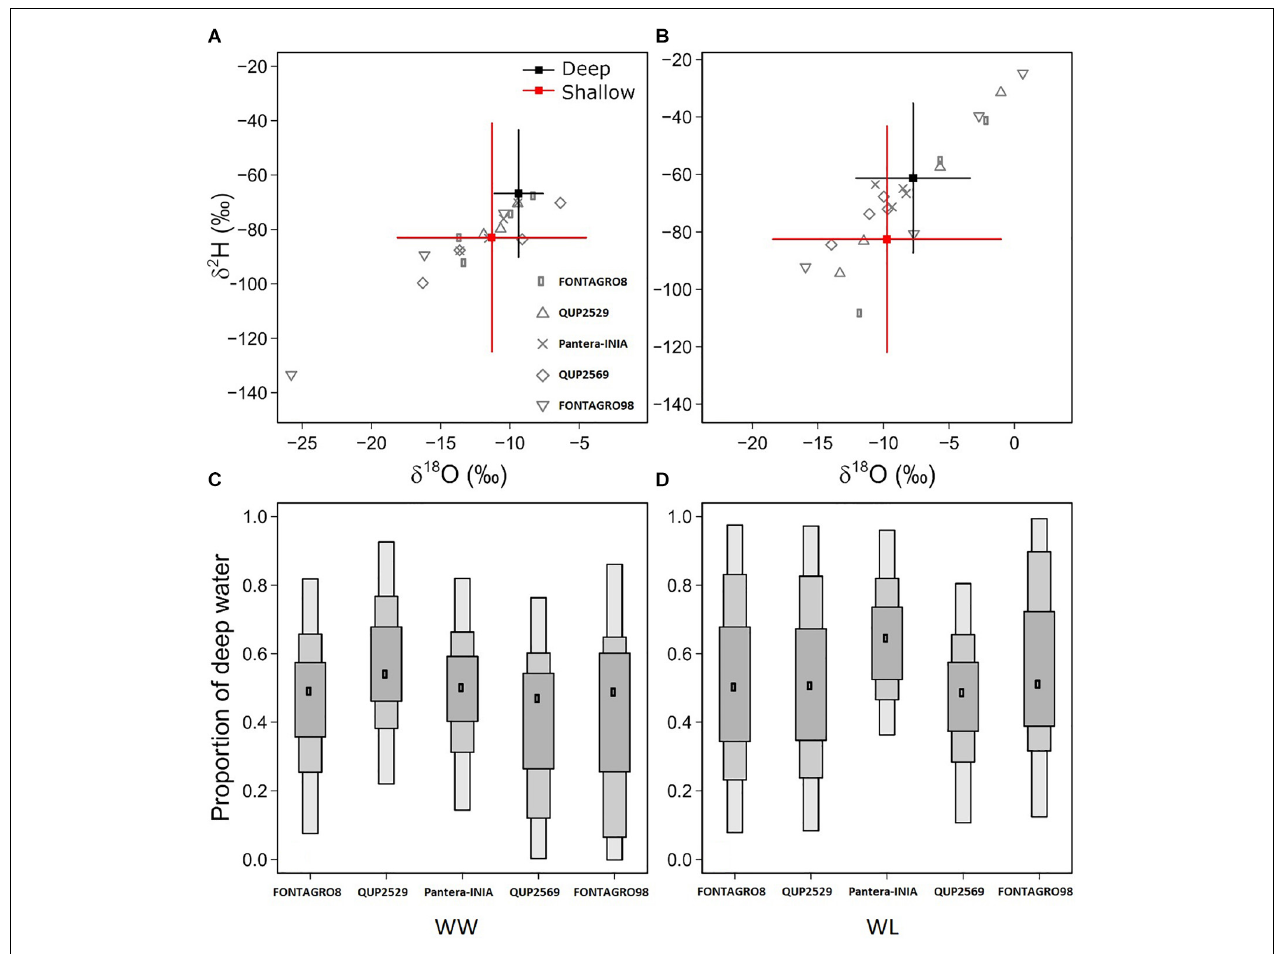
FIGURE 3 | Quantification of the proportion of water uptake from deep soil depths in the 2017 trial, based on Bayesian isotope mixing models. The biplots show the oxygen and hydrogen isotope composition ( δ 18 O, δ 2 H) in basal stem water (as a surrogate of xylem water), and the reference values (sources) of deep and shallow soil water, for WW (A) and WL (B) plants. The box plot indicates the mode and the 95, 75, and 50% credible intervals for the estimated proportion of root collar water derived from deep soil depths, in WW (C) and WL (D) plants.